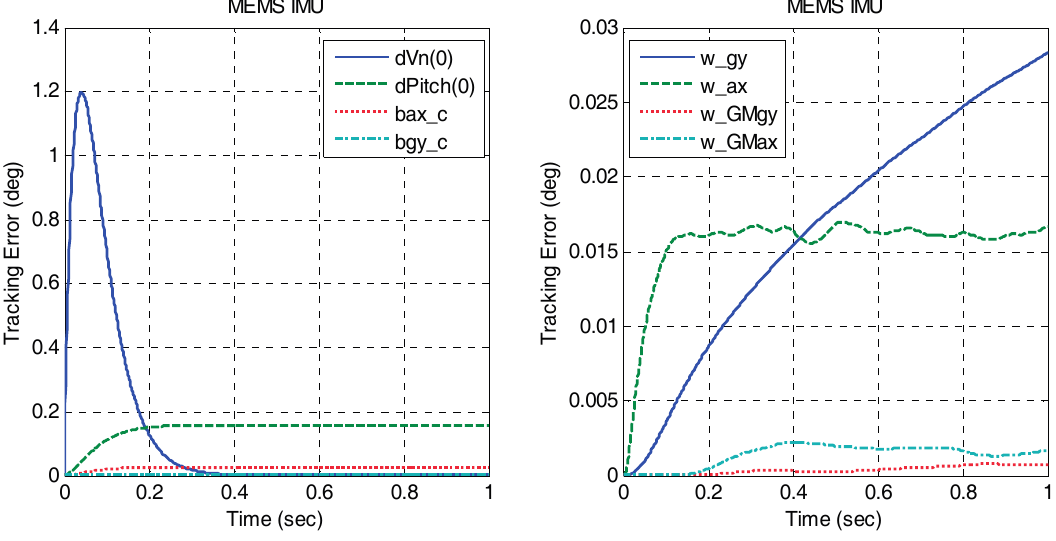
Figure 8. Carrier phase tracking errors caused by the maneuver-independent velocity error sources of MEMS IMU.